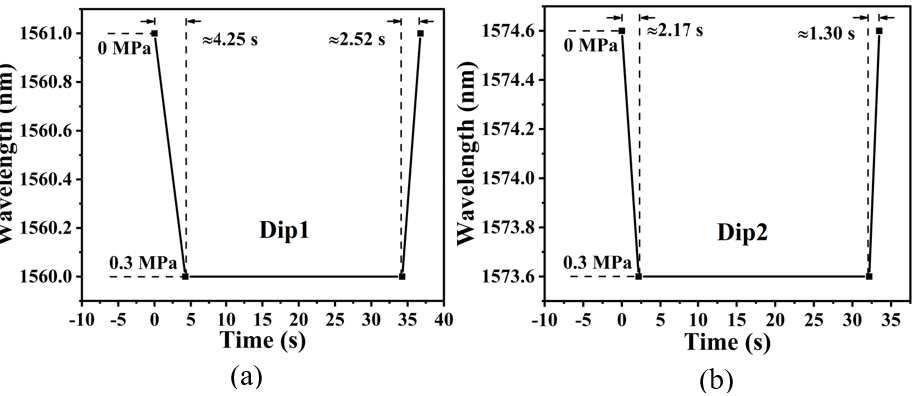
Figure 8. Comparison graphs of response times: ( a ) Response time of single-hole sensor; ( b ) Re- sponse time of ten-hole sensor.